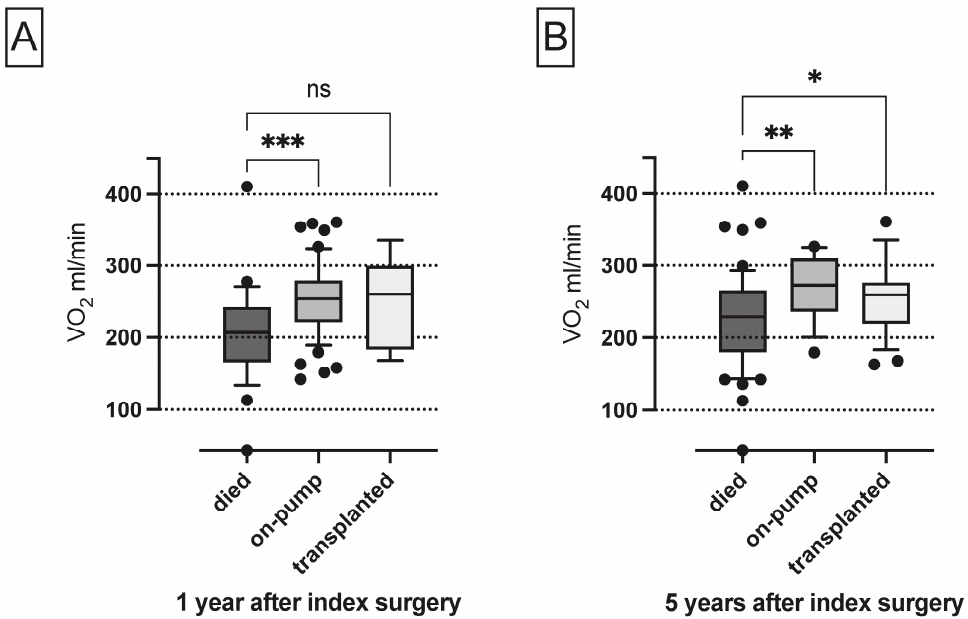
Figure 2. VO 2 levels during the fi rst 4 days after surgery of 1- and 5-years non-survivors, patients on pump and patients undergoing transplantation. ns, not signi fi cant; VO 2 , oxygen consumption; * p < 0.05, ** p < 0.01, *** p <